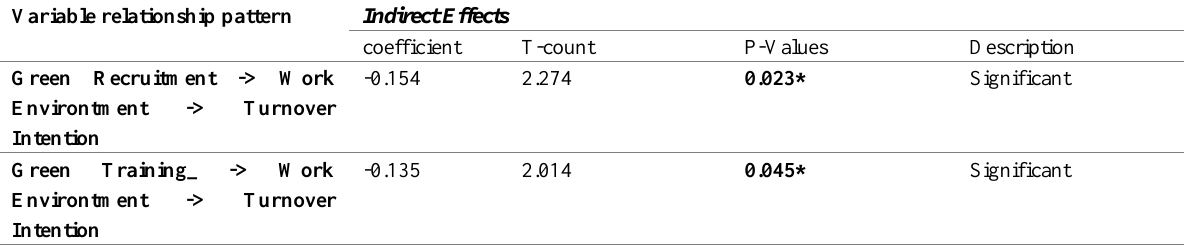
Table 7: Indirect Effect Test